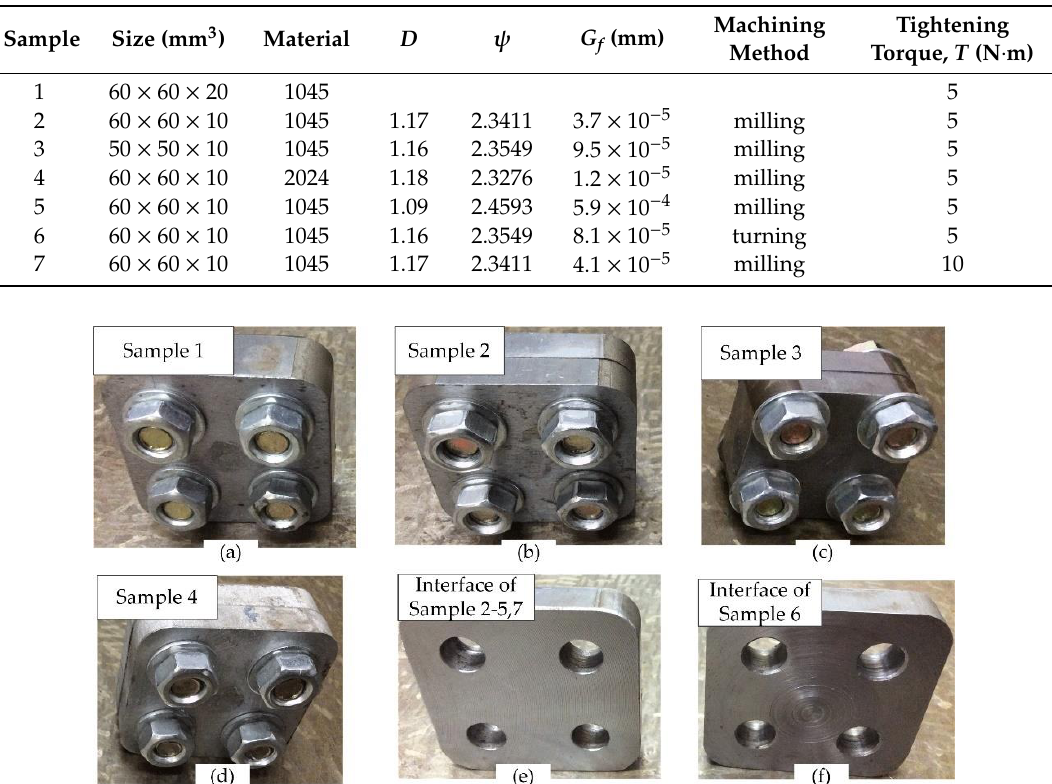
Figure 3. Some photos of different samples and interfaces. ( a ) Sample 1; ( b ) Sample 2; ( c ) Sample 3; ( d ) Sample 4; ( e ) interface of Sample 2–5, 7; ( f ) interface of Sample 6.